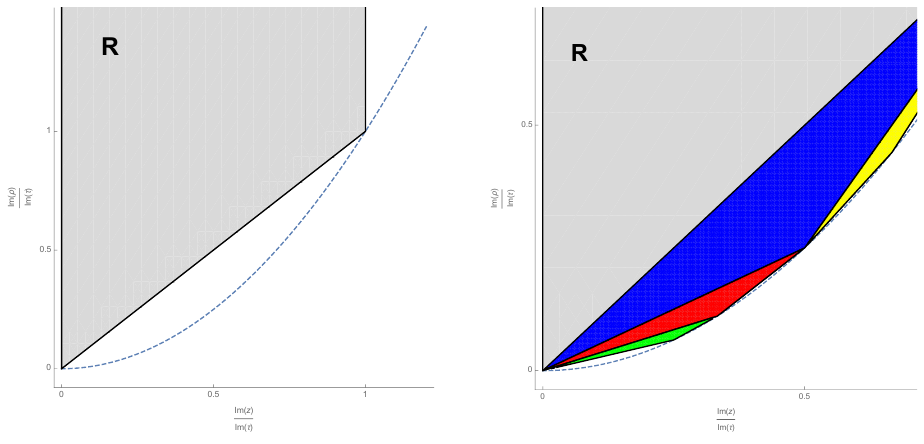
Figure 1 . The plot to the left shows the chamber R (shaded grey region) for 1 = (cid:8) 10 , i.e. t = 1. The dashed line corresponds to the boundary of the Siegel upper half plane; the solid lines correspond to (4.15) . The plot to the right shows the tessellation of H 2 , which is produced by considering further lines in H 1 (1); each colored region represents a new chamber which is surrounded by the appropriate divisor in